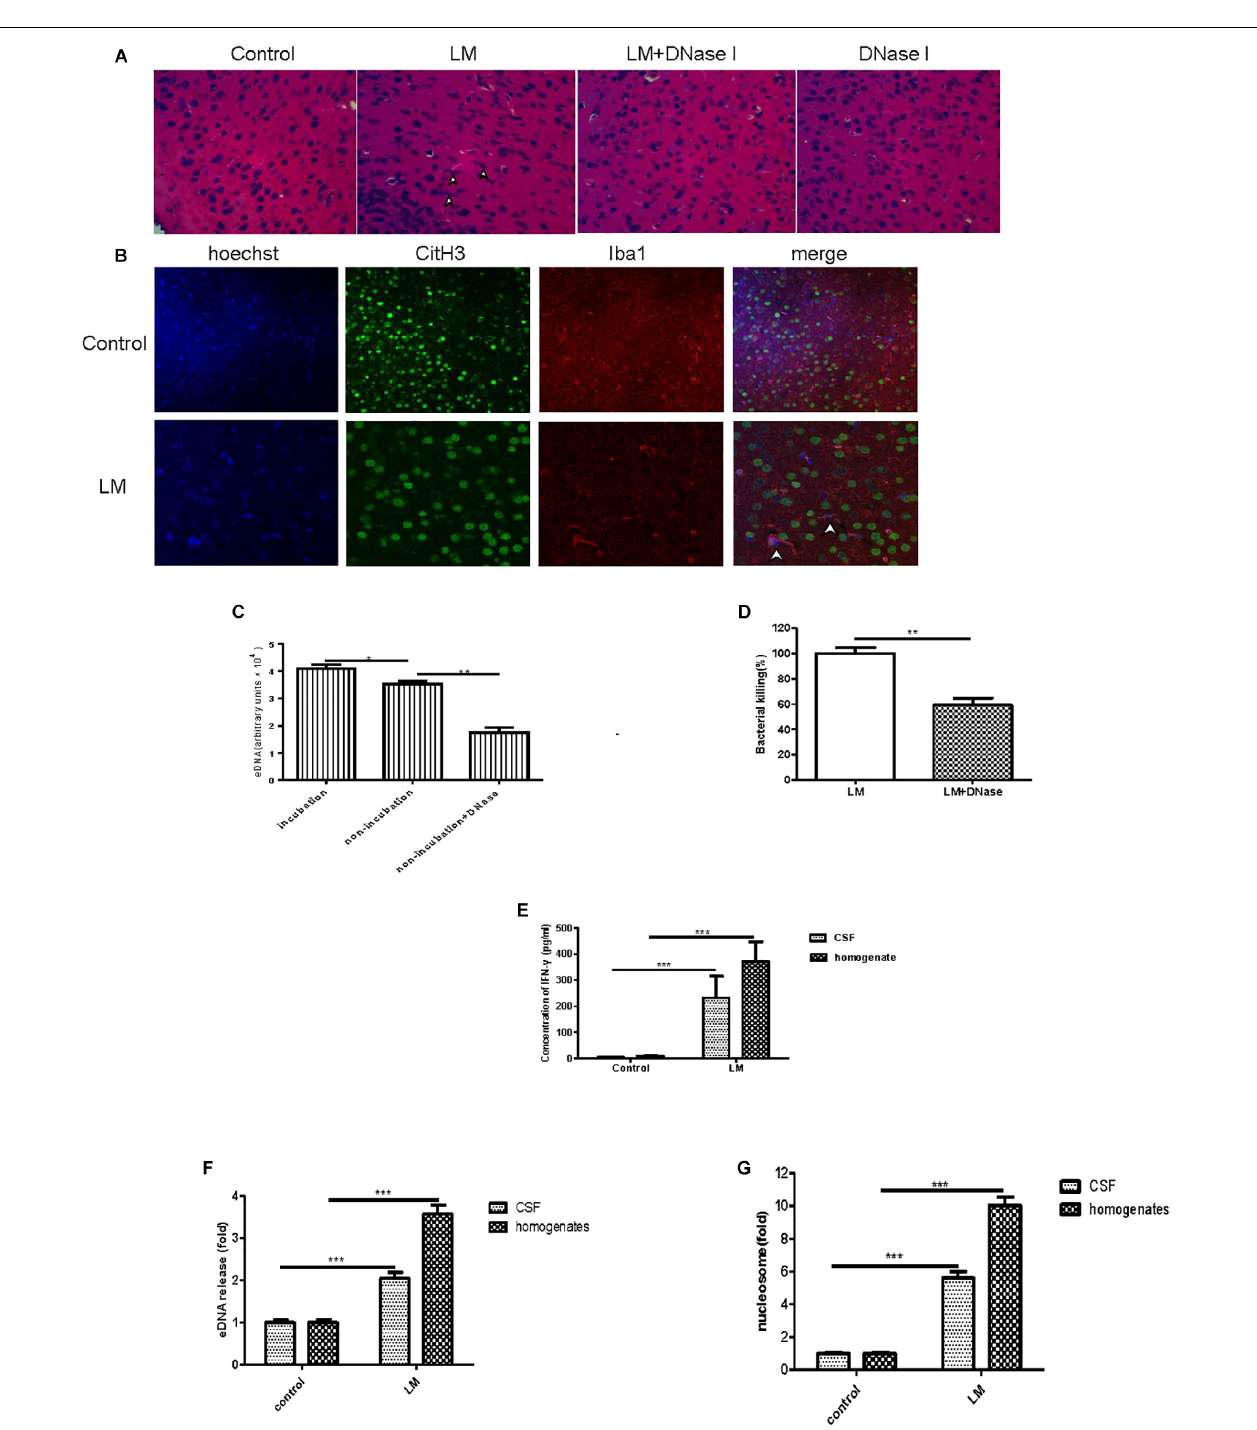
FIGURE 8 | In vivo and in vitro MiET formation and bacterial killing in a mouse meningitis model. The brain parenchyma of mice was injected with Listeria (1 × 10 5 ) or DNase I; PBS injection was used as a control. After 24 h, the mice were euthanized to obtain their brains for paraffin sections. H&E staining of brain tissue slices was observed by microscope with a 40 × objective lens (A) . Colocalization of histone (H3 antibody), microglia (Iba-1 antibody), and eDNA (Hoechst 33342) was observed by confocal microscopy with 20 or 40 × objective lens (B) . eDNA contents were detected after the addition of DNase I (40 U/ml) to the CSF samples (C) . The Listeria meningitis mouse model was established for 24 h with or without DNaseI (5 µ g), then, the bacteria killing rate was calculated (D) and the level of IFN- γ in both the CSF and homogenates was detected (E) . The level of eDNA release in CSF and homogenates (F) from Listeria -infected mice were detected with a plate reader following Sytox green staining. The nucleosome contents of the CSF and homogenates (G) were detected with an ELISA kit. ∗ p < 0.05, ∗∗ p < 0.01, ∗∗∗ p < 0.001. The data are representative of triplicate experiments and presented as the mean value ± the SEM.